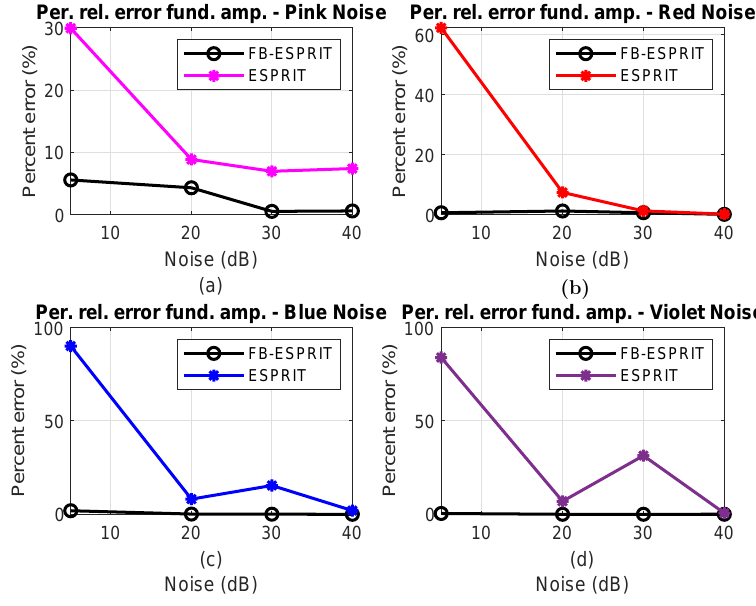
Figure 10. Percentage of relative (Per. rel.) error (%) of 60 Hz fundamental component amplitude (fund. amp.): ( a ) signal contaminated with pink noise; ( b ) signal contaminated with red noise; ( c ) signal contaminated with blue noise; ( d ) signal contaminated with violet